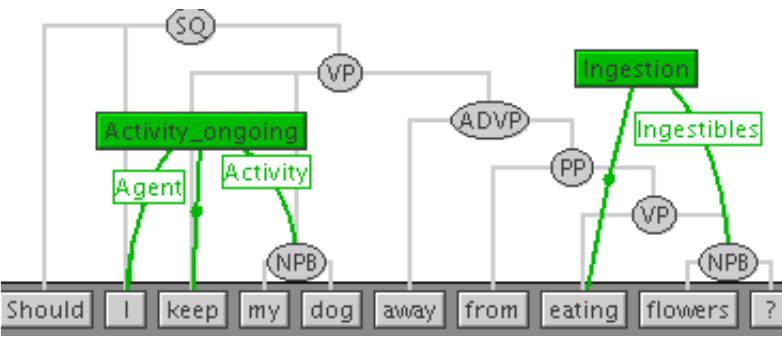
Figure 1 . An example of